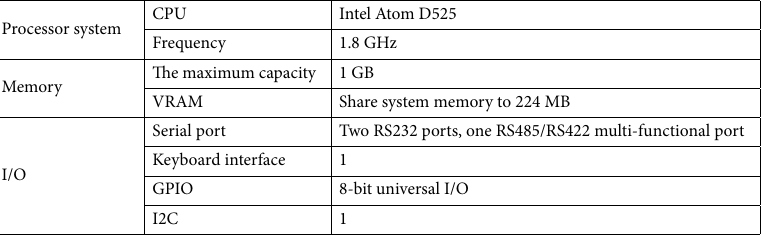
Table 2. Parameters of the controller.